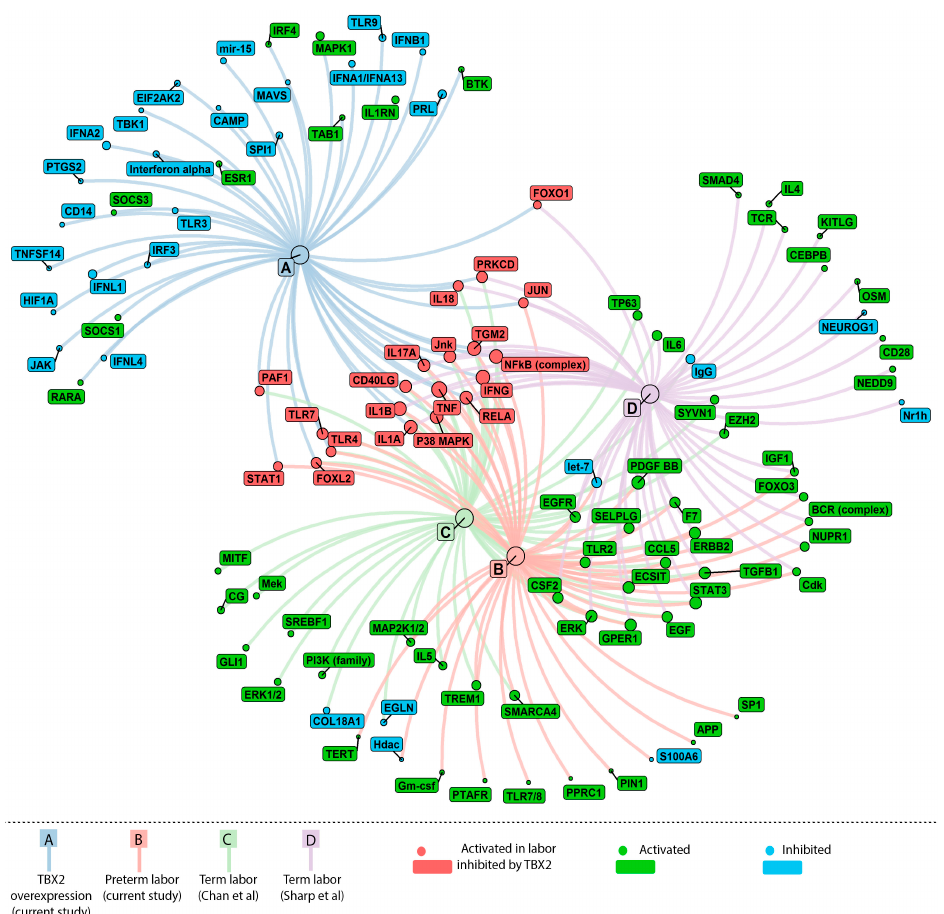
Figure 6. Upstream regulators governing preterm and term labour.